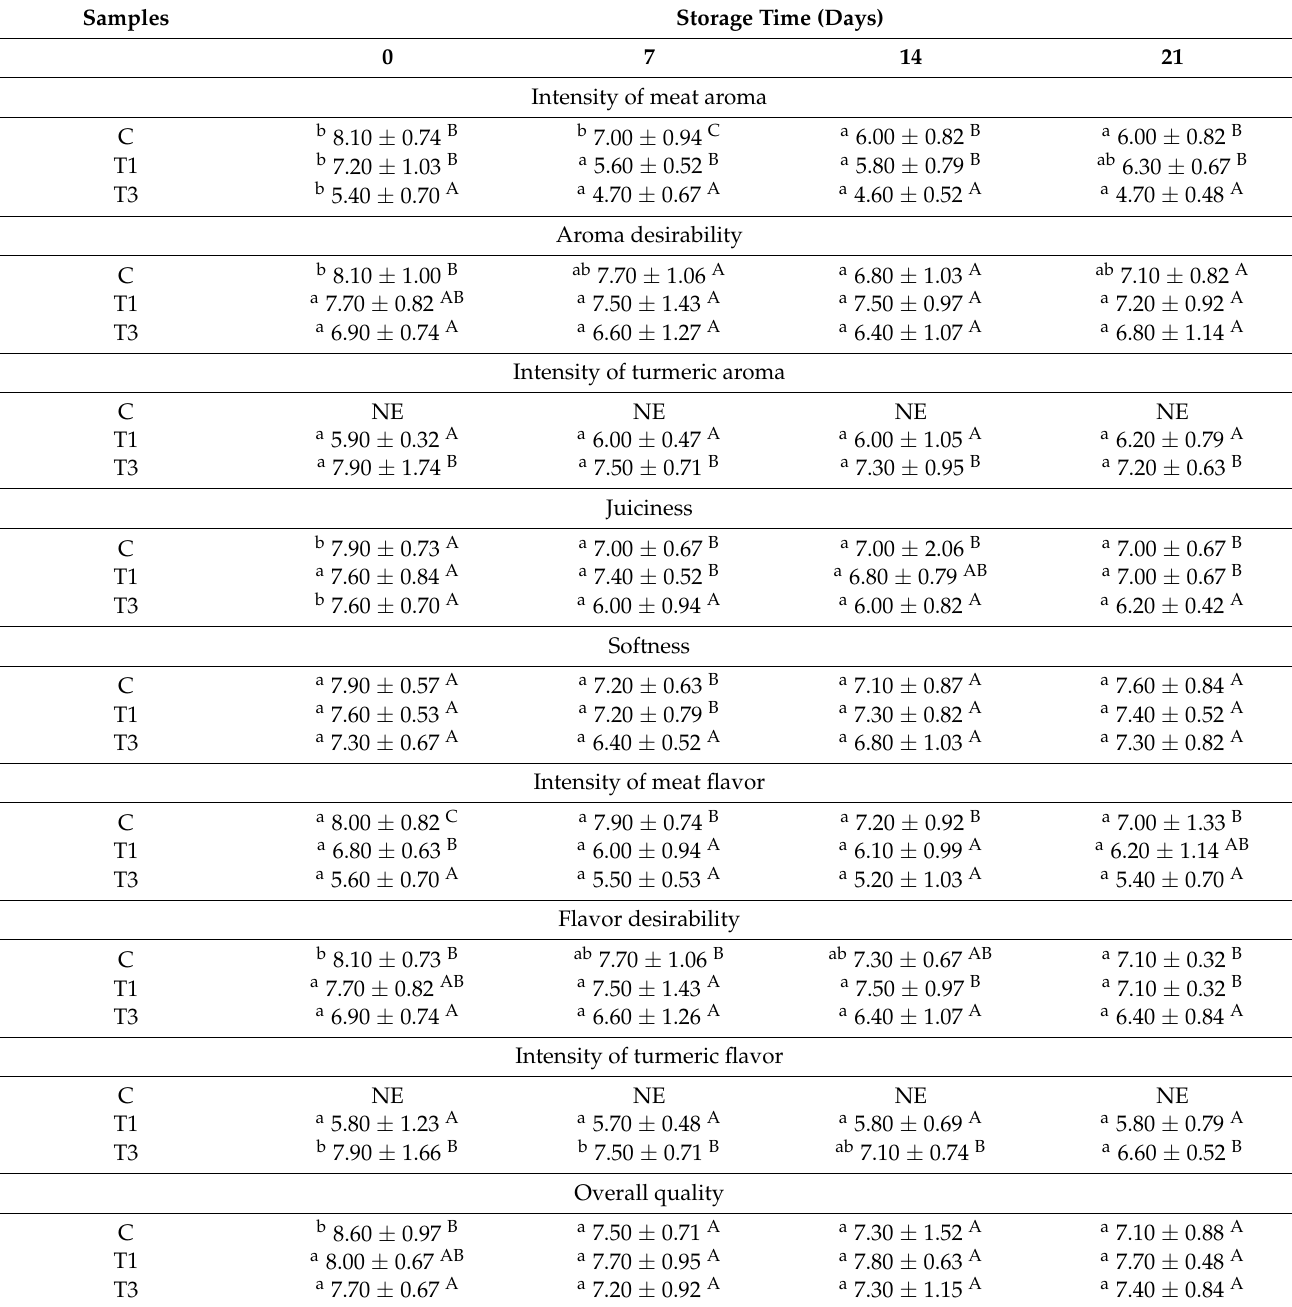
Table 2. The effect of different concentrations of turmeric and storage time on the sensory quality of hermetically packed pork